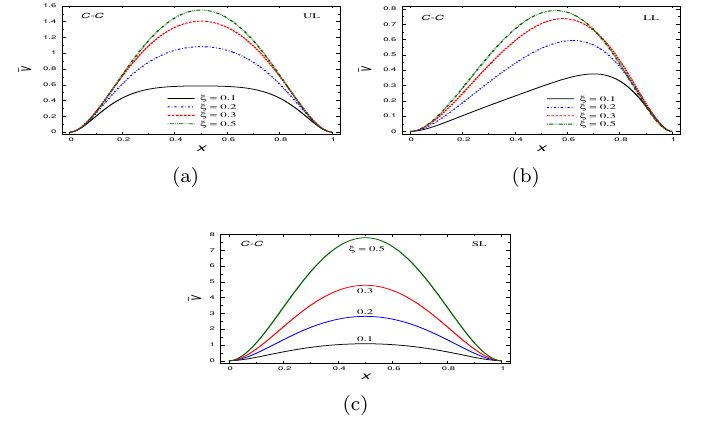
Figure 2. Effect of nonlocal parameter ξ on the distribution of angular displacement along the axial direction of a C-C CNT subjected to: (a) UL, (b) LL, and (c) SL.